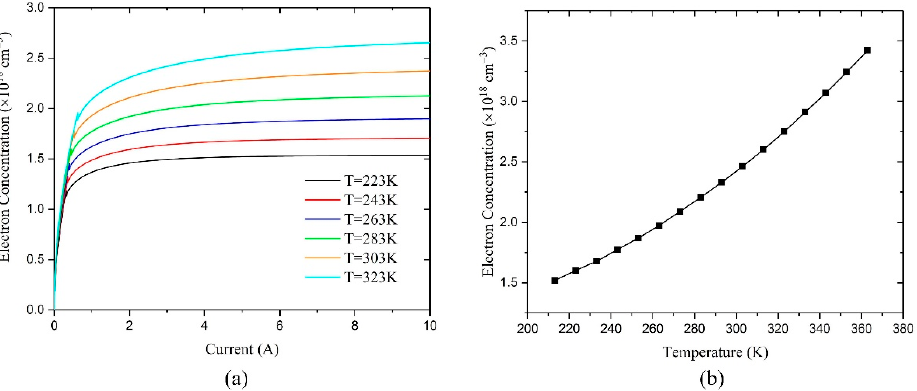
Figure 6. Temperature effects on electron concentration at the center of quantum well ( a ) electron concentration vs. injection current at different temperatures ( b ) electron concentration vs. temperature at an injection current of 10 A.